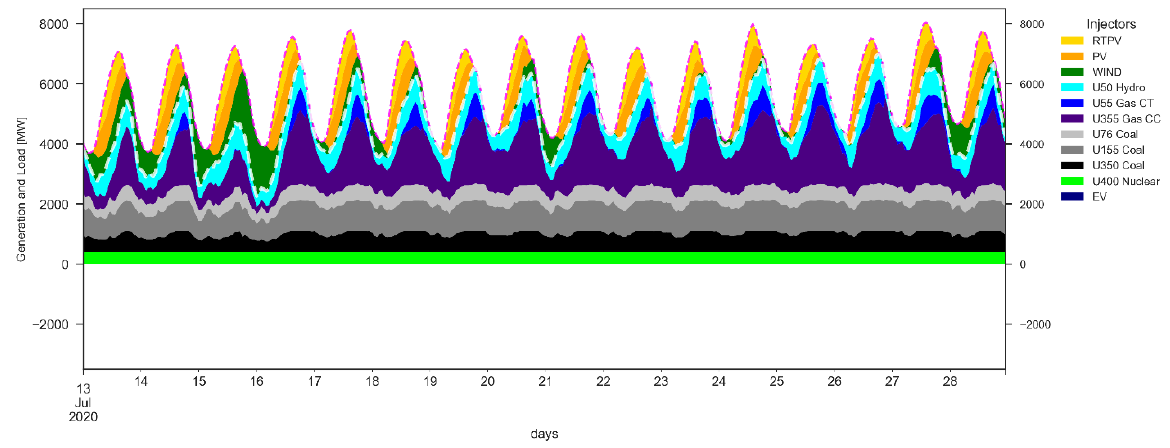
Figure 7. The generation stack for the peak weeks in July, assuming no EV charging.